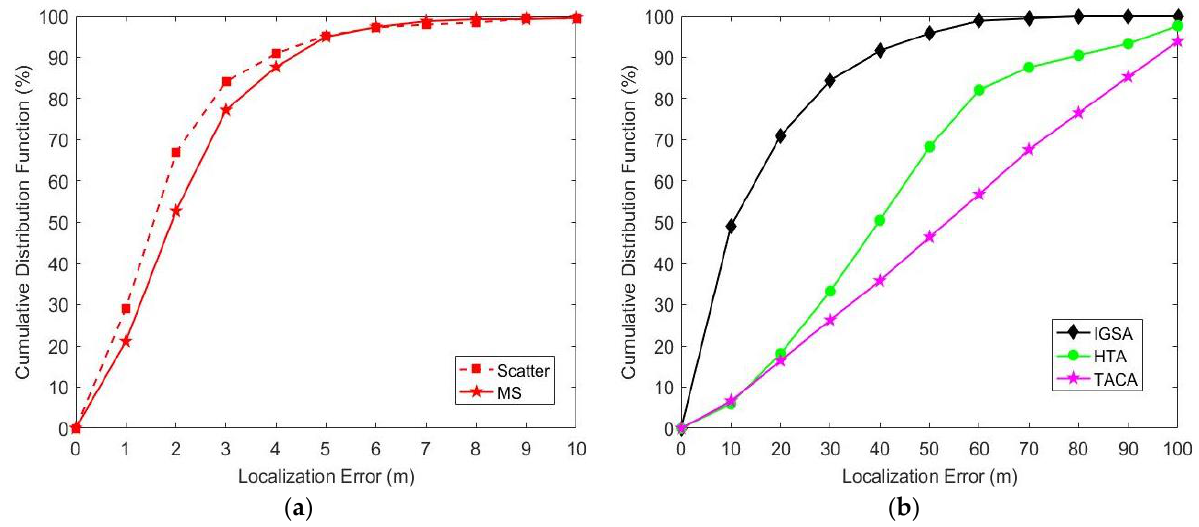
Figure 9. Localization error CDFs curve for ROS model. ( a ) The curve of proposed algorithm; ( b ) The curve of IGSA, HTA and